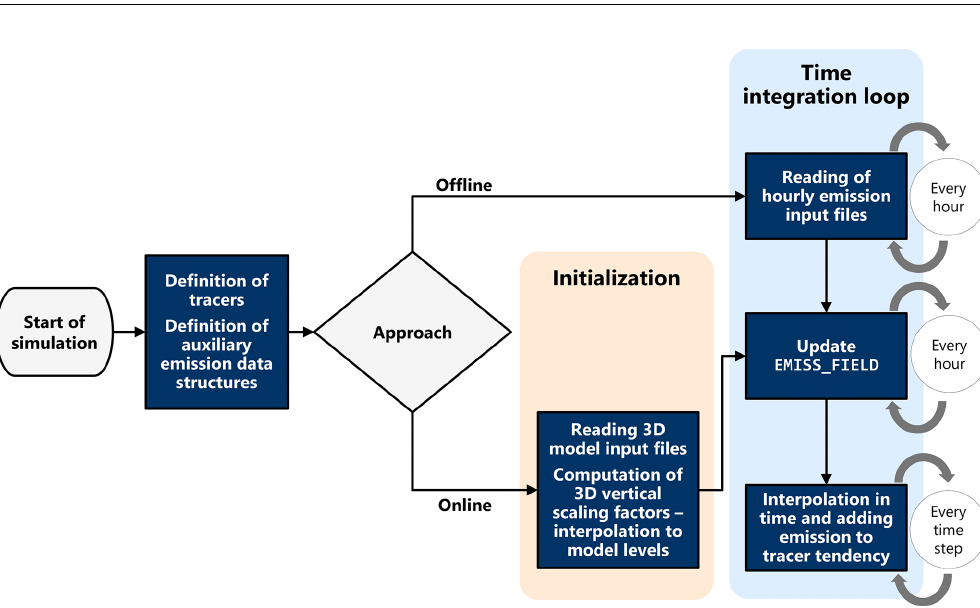
Figure 2. Flow chart for COSMO-GHG run-time processes both for the offline and the online approach. Blue rectangles are code parts. The simulation start point is represented by an oval.